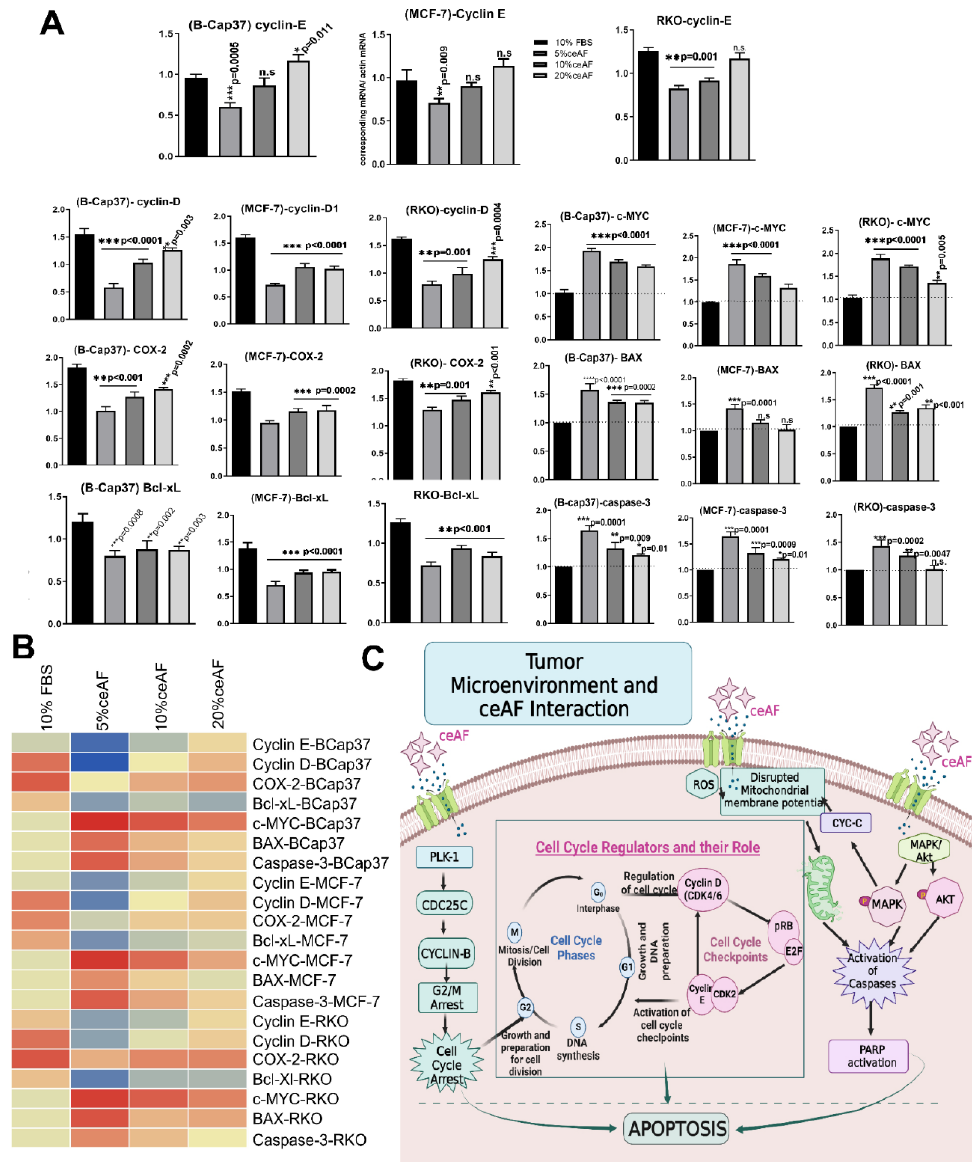
Figure 4. ceAF downregulates the pro-apoptotic genes in a dose-dependent manner. Quantitative real-time PCR analysis of tumor cells treated with different fractions of ceAF (5, 10, and 20% v / v ) is shown. ceAF down-regulates cyclin D and E most effectively in the 5% ceAF group, which shows arresting a maximum number of cells at the G1 phase in the results above ( A ). A comprehensive summary of gene expression is shown in the heatmap ( B ) in the left bottom panel ( B ). All experi- ments were performed three times independently, whereas data represents as mean ± SD * p < 0.05 ** p < 0.001 and *** p < 0.0001. ( C ) ceAF signals tumor cells to undergo apoptosis via cell cycle arrest and MAPK-Akt signaling thereby restricting the growth and proliferation of cells. The declined expression of PLK-1 results in significant expression of CDC25c, which signals cyclin B (cell cycle checkpoint) to halt the G2/M transition of the cell cycle. This also checks and arrests the cells at differ- ent phases of the cell cycle-regulated by other checkpoints, including cyclin D and cyclin E. The further possible activation that ceAF may regulate is the activation (phosphorylation) of MAPK-Akt signaling pathways, which activates a series of caspases to undergo apoptosis. Moreover, ceAF regulates the expression of reactive oxygen species (ROS) in the tumor microenvironment, which can disturb the mitochondrial membrane potential ( ∆Ψ m), thereby rupturing the tumor cells’